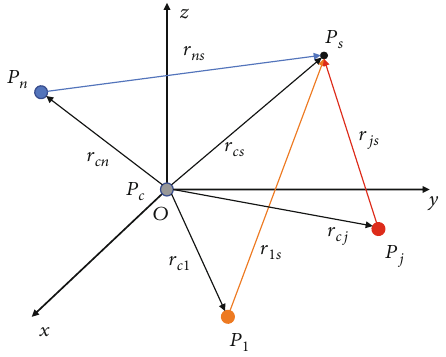
Figure 1: The motion of spacecraft in the full ephemeris